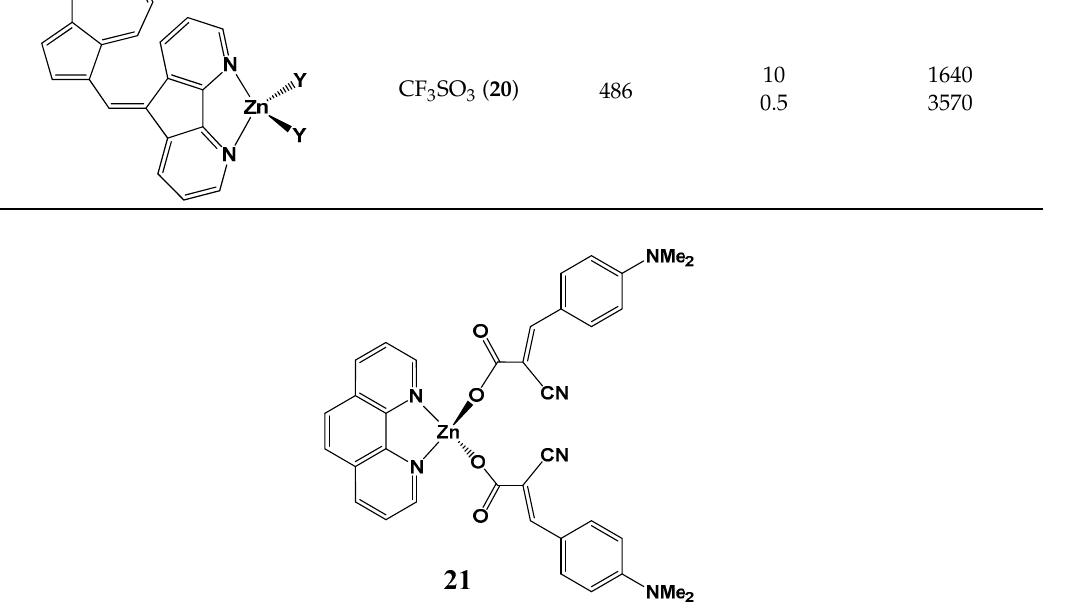
Figure 3. Zn(II) phenanthroline complex bearing a push–pull carboxylate ligand.